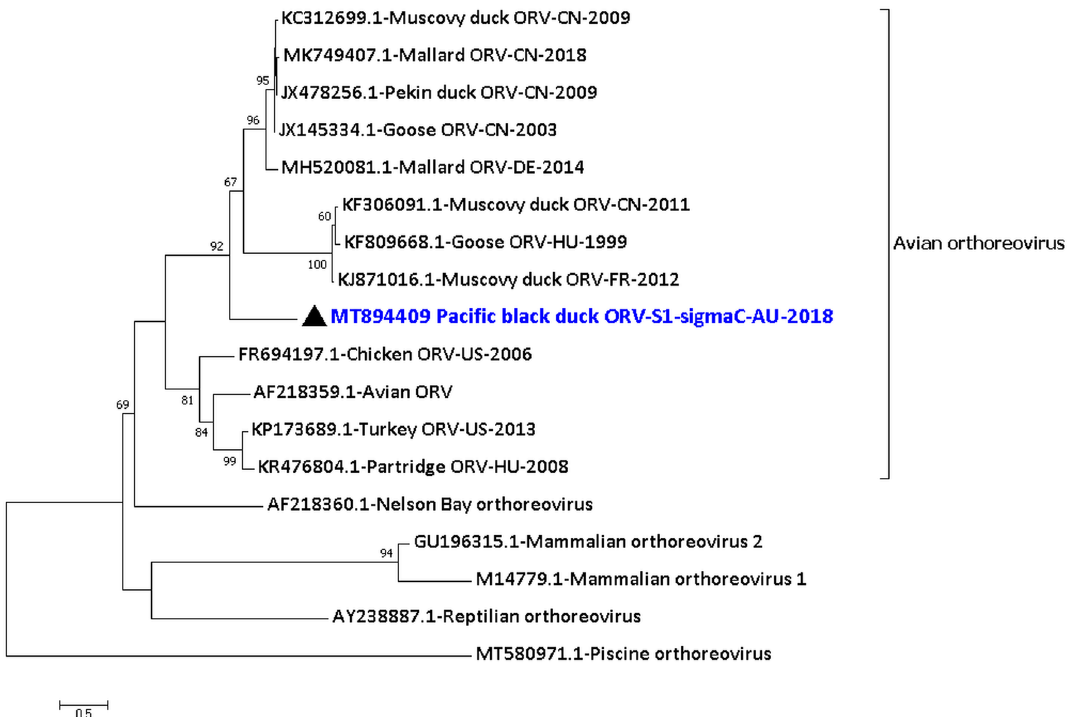
Figure 3. Phylogenetic analysis of the amino acid sequences of the sigma C protein of Pacific black duck orthoreovirus segment S1 (PBDORV/S1/PBD08.18). The amino acid sequences were aligned and analysed by using the maximum likelihood method based on the WAG + G + F model 73 in MEGACC 74 with a bootstrapping of 1000 replicates. The analysis involved 18 amino acid sequences and all positions containing gaps and missing data were eliminated. The final dataset contained a total of 257 amino acid positions. The numbers at the nodes represent bootstrap values and only bootstrap values at or above 60% are shown. Pacific black orthoreovirus is shown in blue and marked with a black triangle. No orthologous sigma C protein was found in Broome ORV, Baboon ORV and Mahlapitsi